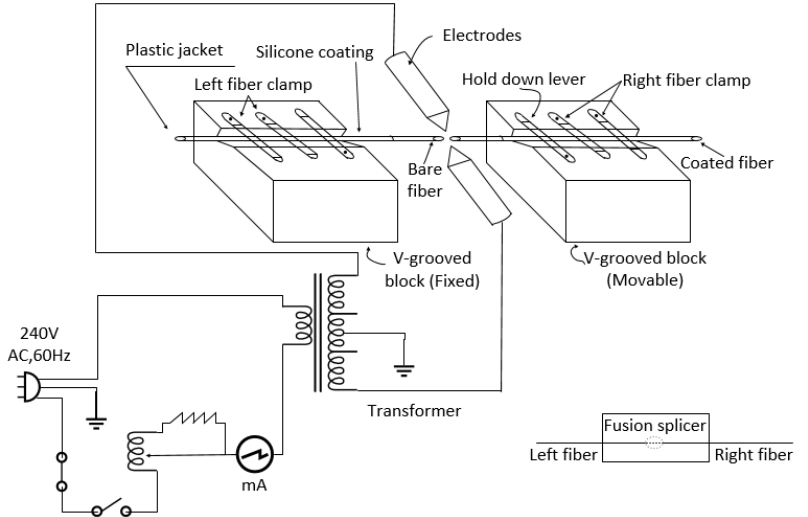
Figure 1. Splicing set-up, at high altitudes, the fusion splicer is placed on as flat a surface as possible to minimize unnecessary interference, as shown in the lower right corner of the figure. The left and right optical fibers are respectively placed in the V-groove of the fusion splicer, being aligned with each other. Then, the fusion splicer quickly discharges and heats the fiber ends through two electrodes, which makes it fuse and splice together